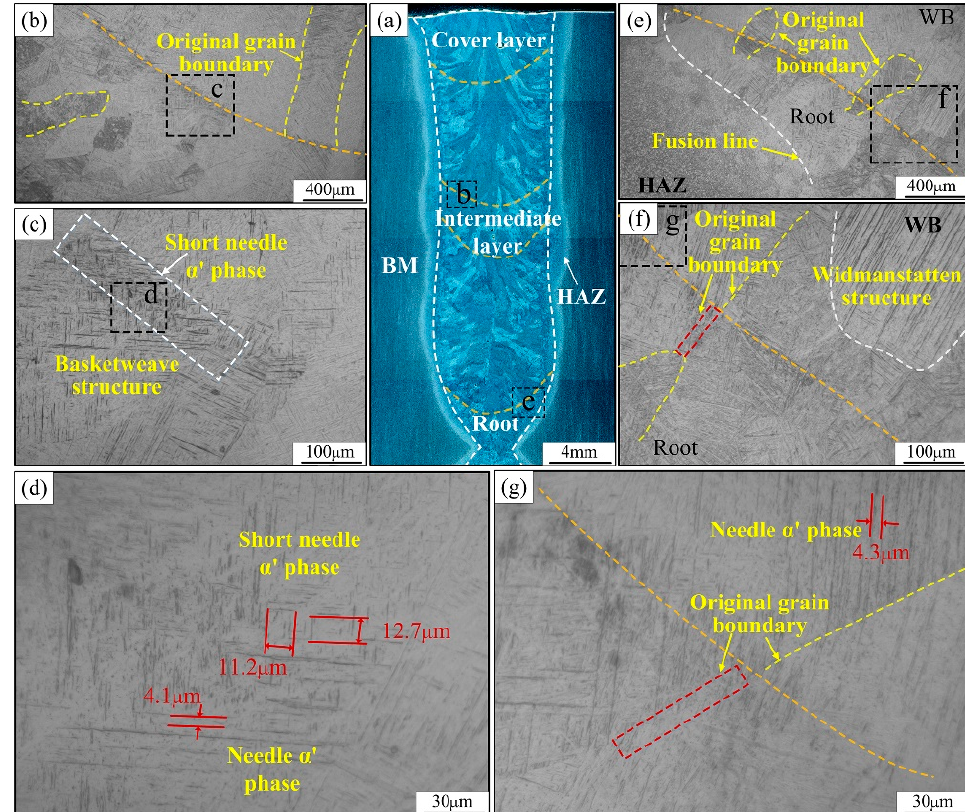
Figure 7. Microstructure of the middle and the lower interlayer weld area of the joint: ( a ) the macromorphology, ( b , c ) the interlayer microstructure in the middle of joint, ( d , g ) the needle-like α ’ phase morphology, ( e , f ) the interlayer microstructure near the root of joint.